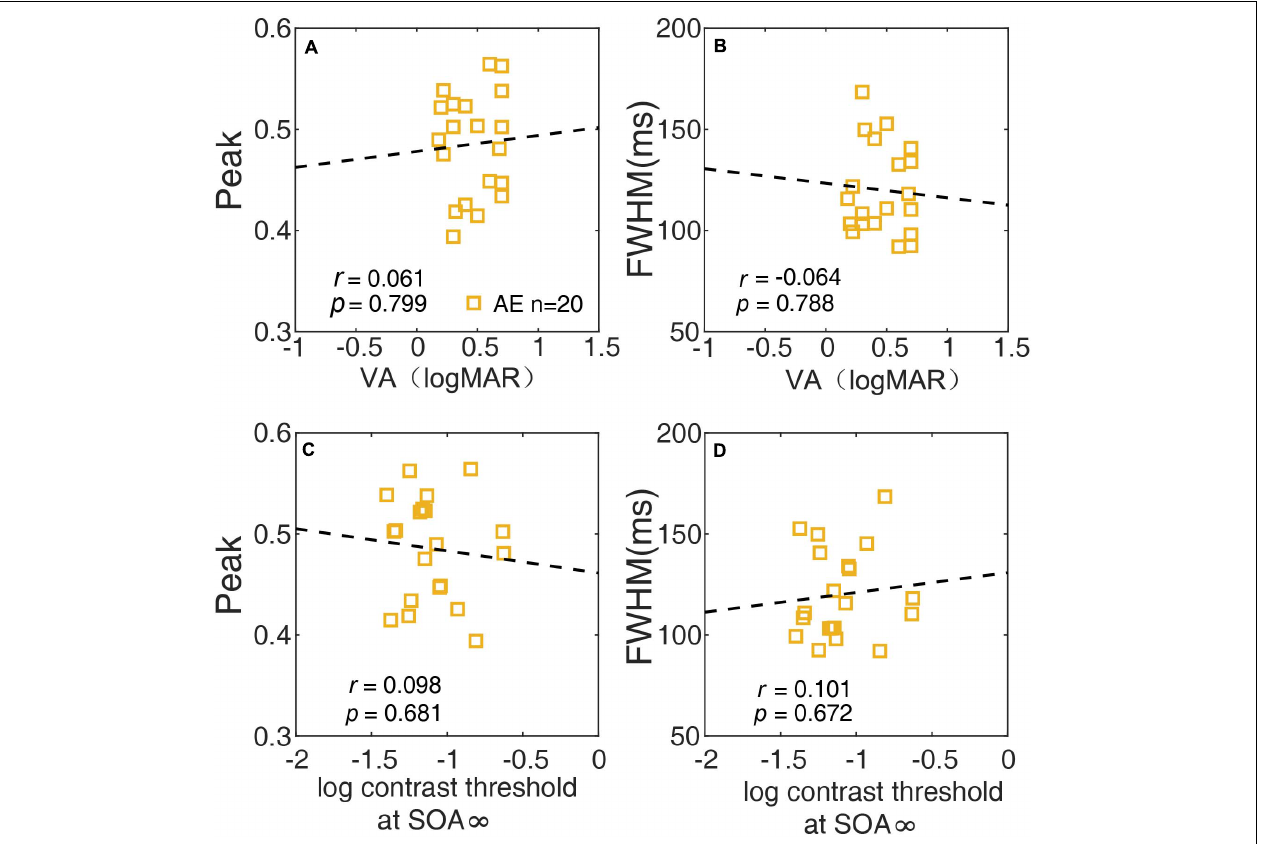
FIGURE 7 | The relationship between the peak of the temporal window and VA (A) , between the width (FWHM) of the temporal window and VA (B) , between the peak of the temporal and contrast threshold at SOA ∞ (C) , and between the width (FWHM) of the temporal window and contrast threshold at SOA ∞ (D) of the AE are